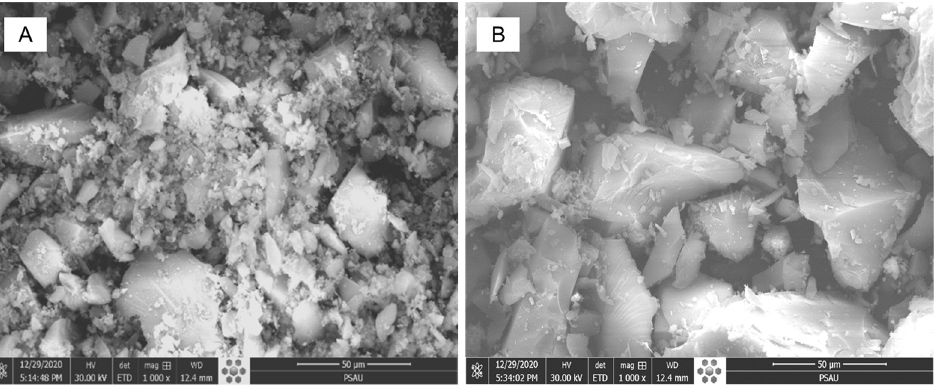
Figure 6. SEM images of the ultrasonically ( A ) and non-ultrasonically ( B ) prepared 1%Pd-HPW/SiO 2 bi-functional catalysts.